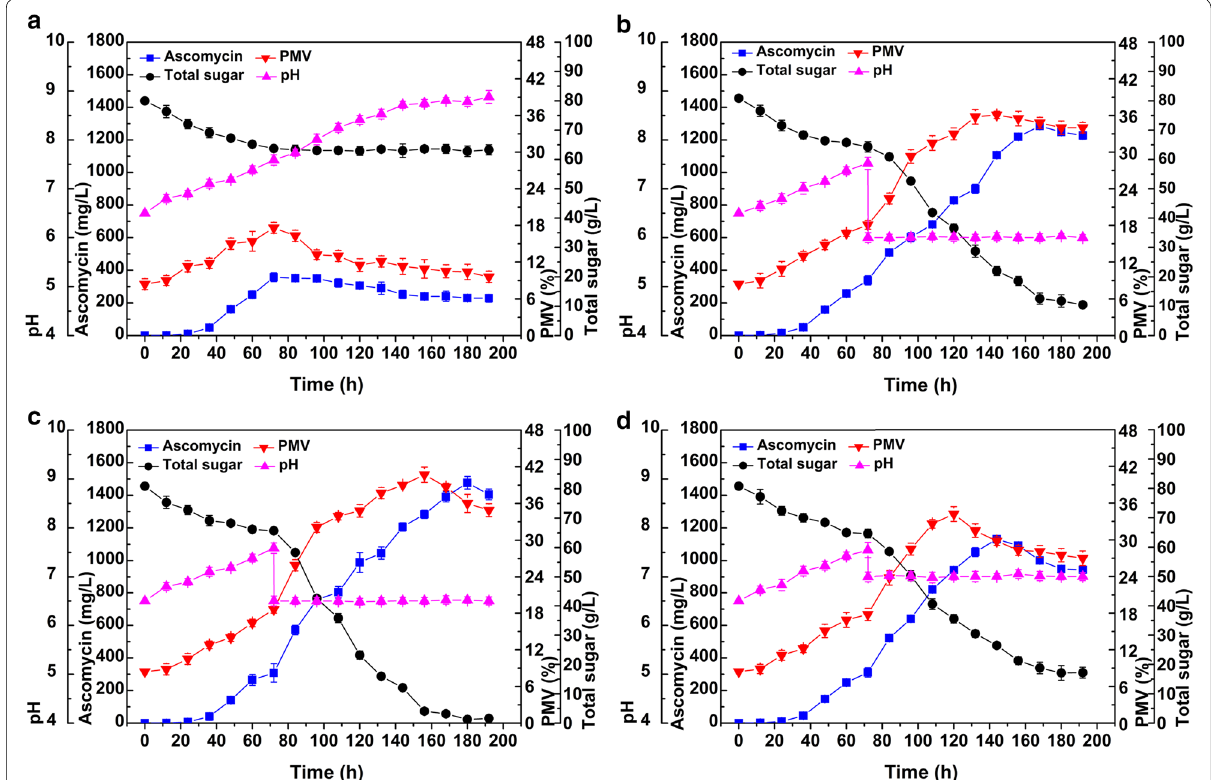
Fig. 7 Scale-up fermentation of S. hygroscopicus SFK-36 under optimized fermentation conditions in a 5 L fermenter. The pH-controlling strategies were conducted with no controlling ( a ), or maintained at a constant pH of 6.0 ( b ), 6.5 ( c ), 7.0 ( d ), respectively